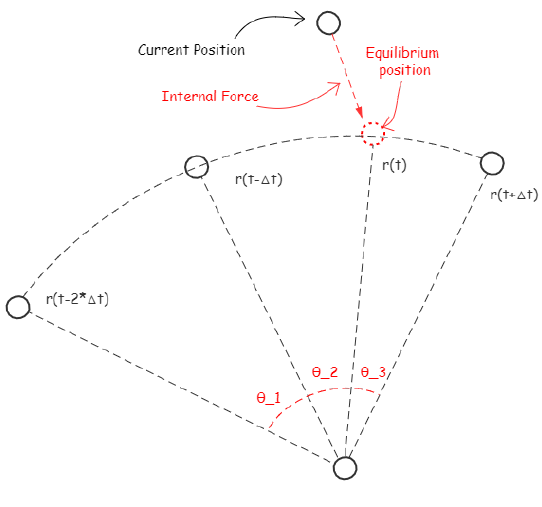
Figure 6. Improved Elastic